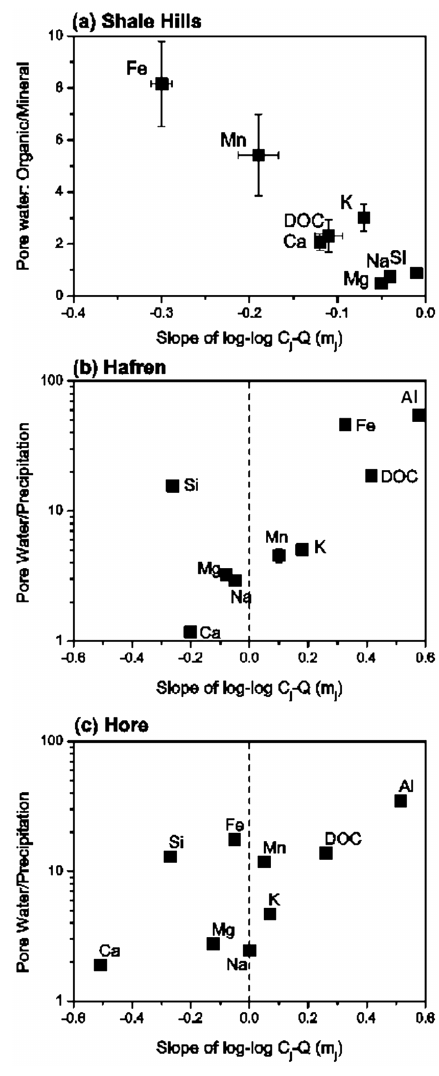
Figure 4. The degree of non-chemostatic behavior for a solute in stream water, denoted by m j , was correlated with the relative con- centration of that solute in organic-rich soil water in each catch- ment. Specifically, m j was (a) negatively correlated with the ratio of solute concentrations in organic-rich versus organic-poor soil wa- ters at Shale Hills ( R 2 = 0.90, p <0.001) and positively correlated with the ratio of solute concentrations in pore waters versus pre- cipitation in (b) the Upper Hafren ( R 2 = 0.48; p <0.05) and (c) the Upper Hore ( R 2 = 0.42; p <0.05). Error bars represent the standard error of each value and are smaller than the symbol where not visi-